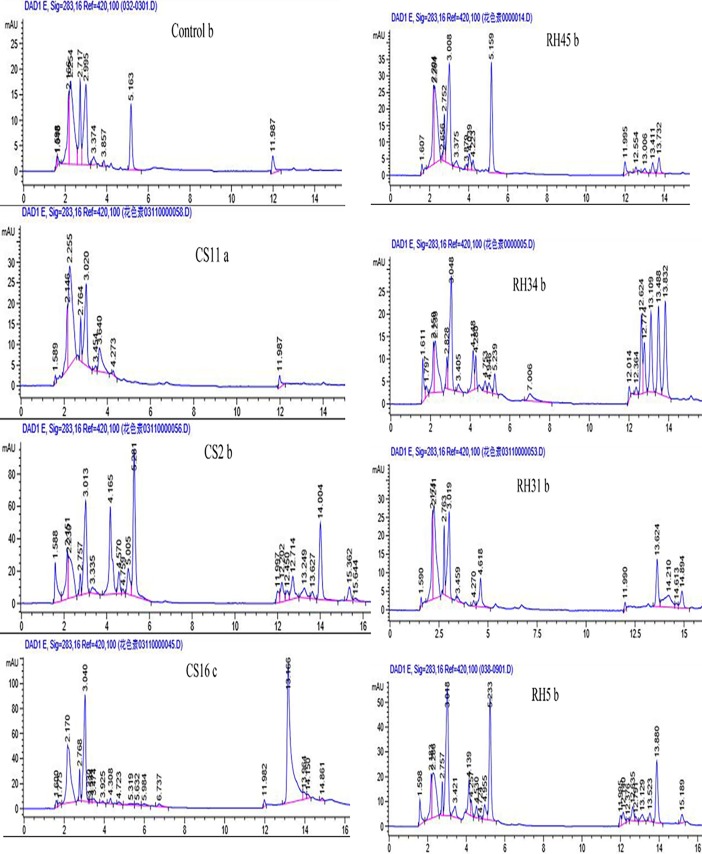
HPLC chromatograms of grape cell extracts after dual-cultured with different endophytic fungal strains (EFS).Chromatograms were selectively displayed in the figure. Each chromatogram was marked the EFS which the grape cells dual-cultured, and the followed letter was the serial number of replicates. Chromatograms of all other detected samples can be found in supplementary materials (S1 Fig).